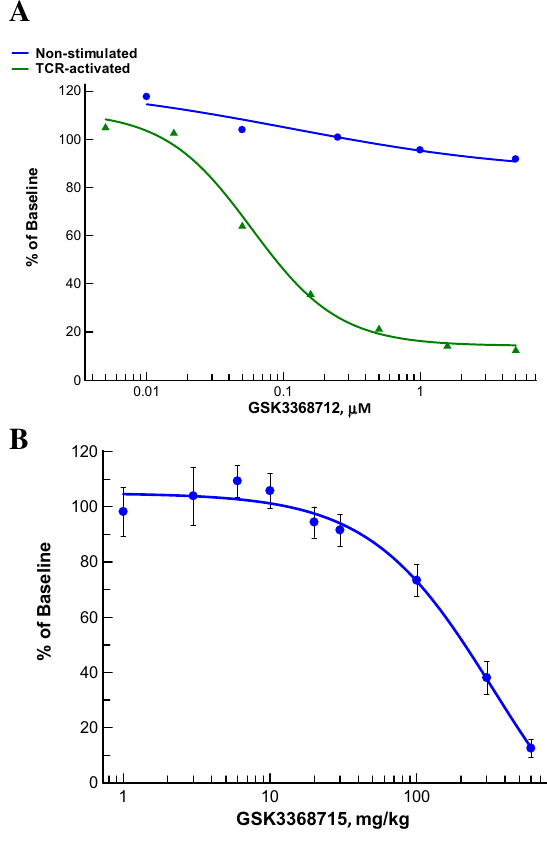
Figure 6. LC–MS/MS quantitation of hnRNP-A1 peptides in human PBMCs and mouse leukocytes. ( A ) Reduction of DM-R225-hnRNP-A1 in human PBMCs treated in vitro with several concentrations of GSK3368712 either without stimulation or in the presence of a TCR-activating agent (CytoSTIM) for 72 h. ( B ) Reduction of DM-R225-hnRNP-A1 in white blood cells from mice (n = 3) treated orally once-daily with several doses of GSK3368715 for 15 days. Levels of DM-R225-hnRNP-A1 were normalized to levels of the hnRNP-A1 154-167 peptide (total protein) and changes calculated as % of baseline DMSO or vehicle controls. Data are expressed as the mean ± standard deviation